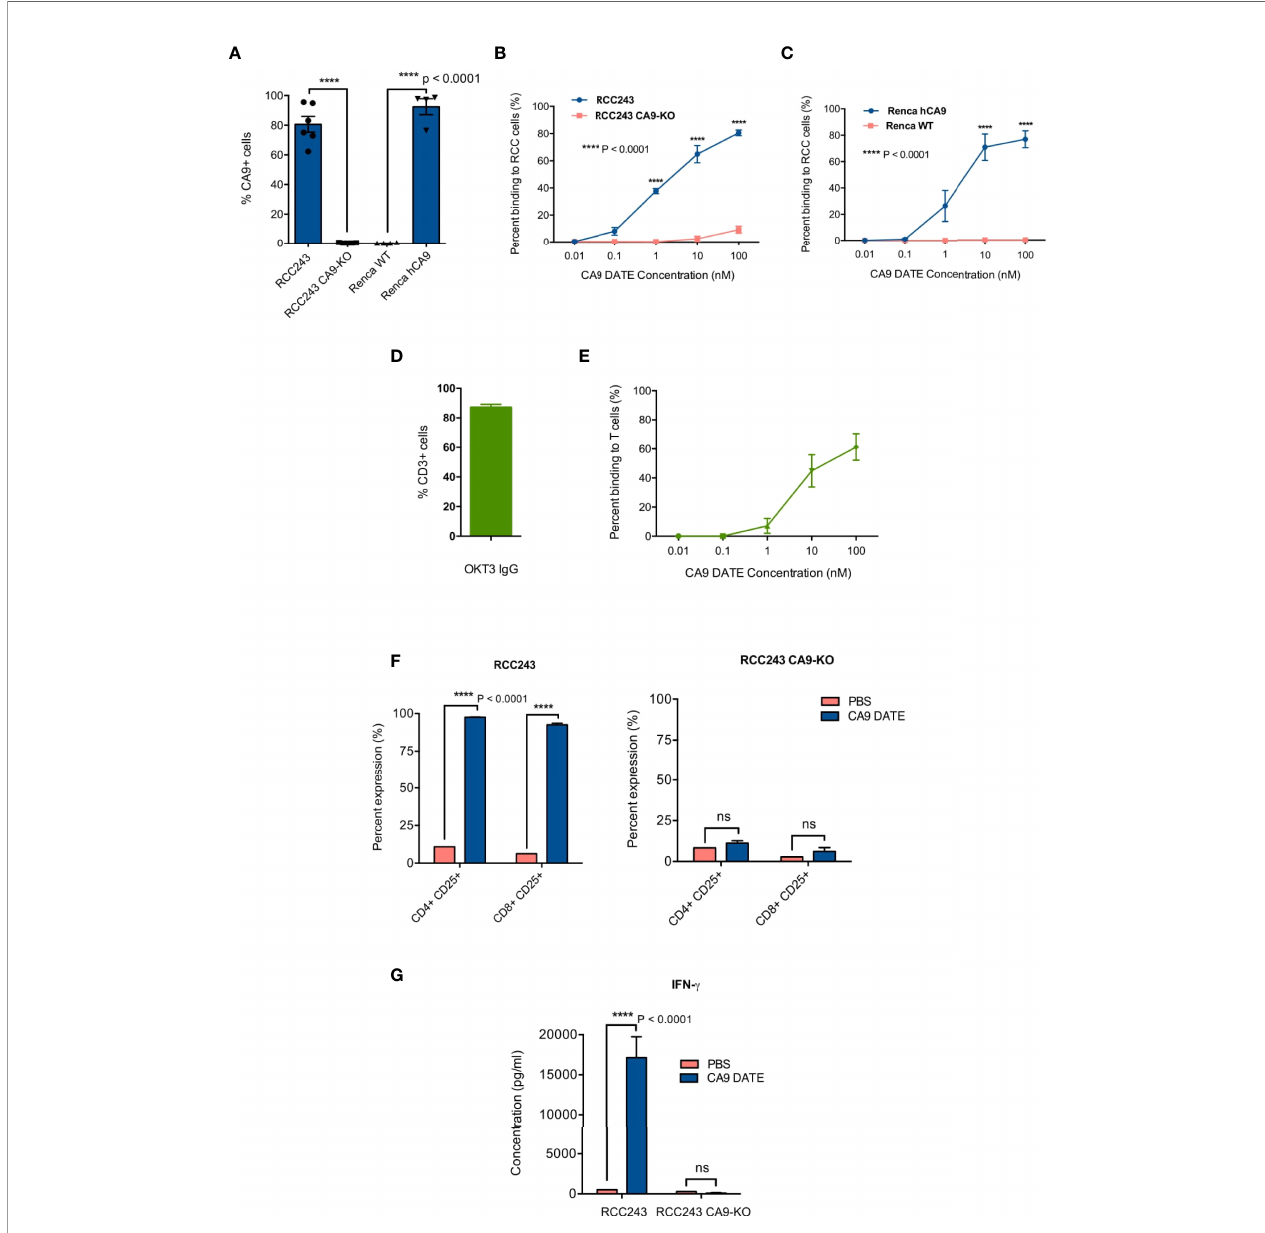
FIGURE 3 | Generation and assessment of human anti-CA9 Dual speci fi c T cell engagers (DATEs) on Renal Cell Carcinoma (ccRCC). (A) CA9 expression level on RCC243, RCC243 CA9-KO, Renca and Renca hCA9 cells. (B) Increasing concentrations of CA9 DATE binding to RCC243 vs RCC243 CA9-KO, (C) Renca hCA9 vs Renca WT cells and (E) CD3 expressing Jurkat cells were measured using fl ow cytometry. Error bars: mean ± SEM. (D) okt3 expression level on Jurkat cells. (F) Addition of CA9 DATEs (1 nM) to the co-culture of human CD3+ T cells with CA9 expressing target cells (Luciferase-expressing RCC 243 cell lines and the CA9 knockout counterpart [CA9-KO]) for 48 hours at the E:T ratio, 1:5 resulted in a signi fi cant elevation of CD25 expression on both CD4+ and eng+ T cells population con fi rmed by fl ow cytometry analysis. (n=4) (P value: **** < 0.0001) (2 way ANOVA) (G) Enzyme-linked immunosorbent assay (ELISA) indicated increased secretion of Interferon-gamma (IFN-y) by T cells only in the presence ofCA9 DATE and CA9 expression on target cells. (P value:**** < 0.0001) (2 way